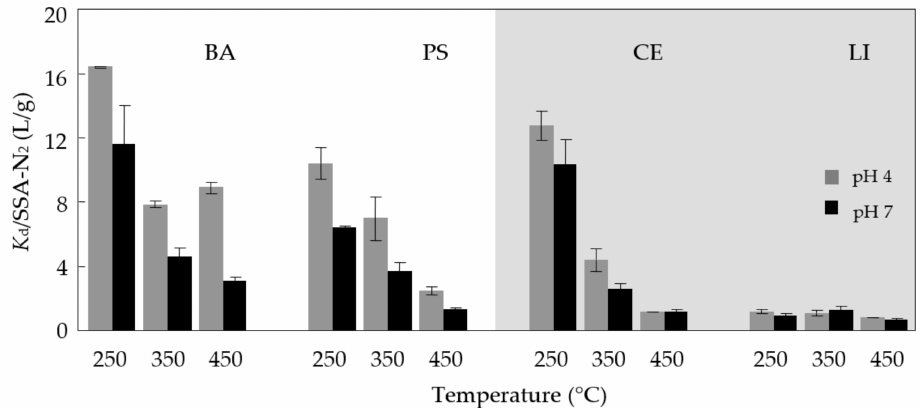
Figure 5. Normalization of sorption coefficients ( K d ) by SSA-N 2 on the calculation of initial concen- tration of 7.0 mg/L onto biochars at pH4 and